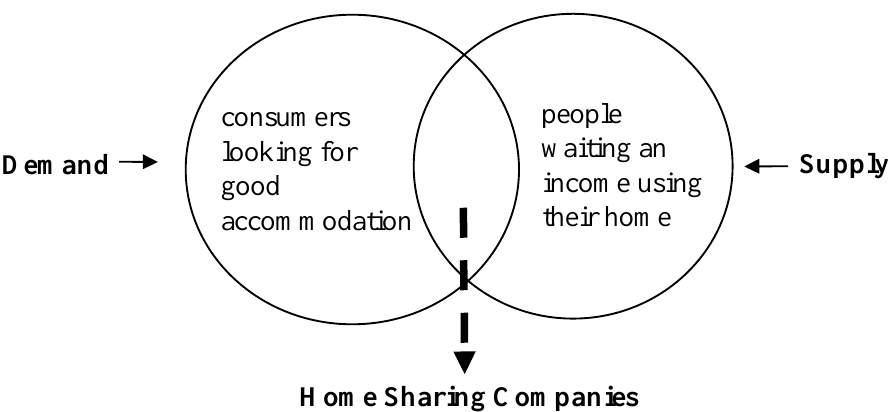
Figure 2: The Sharing Accommodation